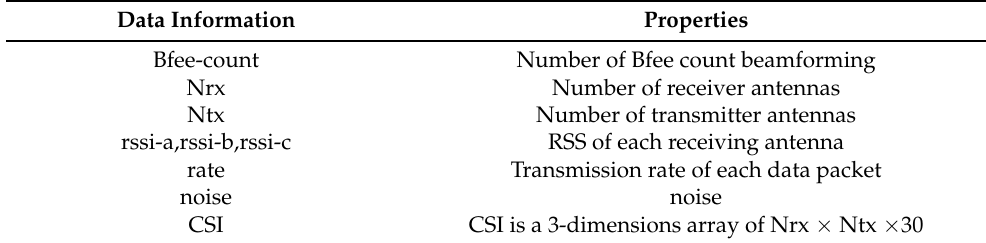
Table 2. Channel state information